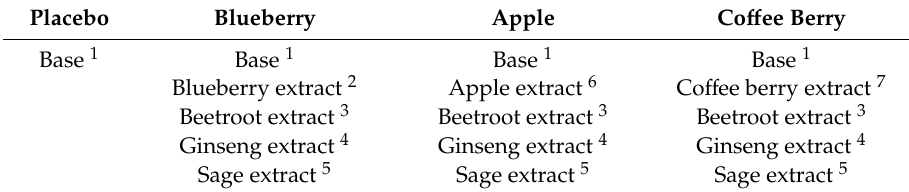
Table 1. Description of the investigational beverages. All beverages were made up to 10 fl